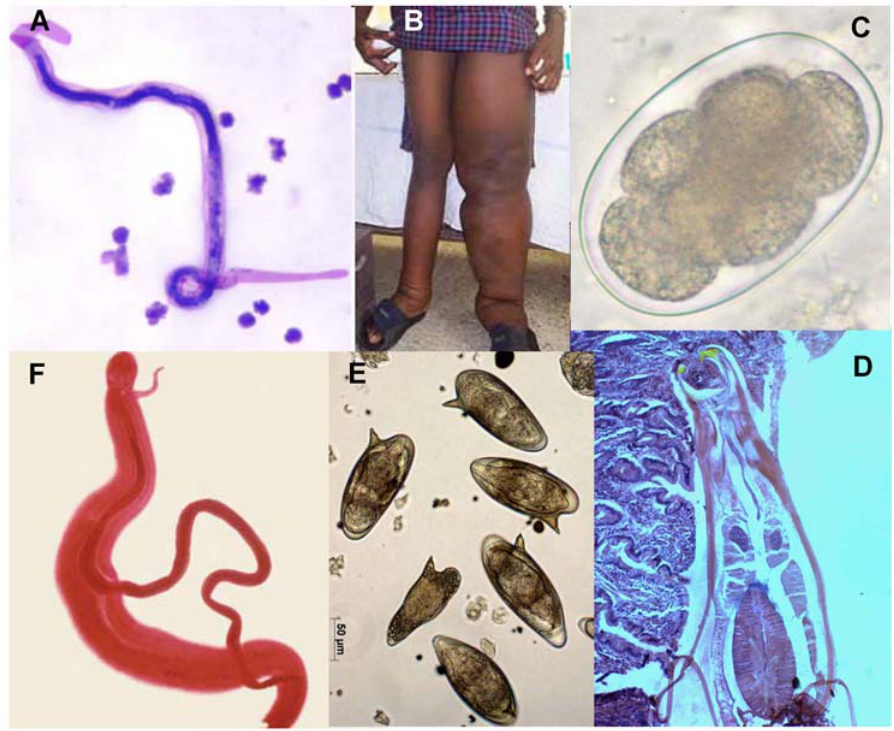
Figure 1. Montage of some of the major human helminth parasites, their developmental stages, and disease pathology. (A) Microfilaria of Brugia malayi in a thick blood smear, stained with Giemsa (http://www.dpd.cdc.gov/dpdx/html/frames/a-f/filariasis/body_ Filariasis_mic1.htm); the microfilaria is about 250 m m in length. (B) Patient with lymphedema of the left leg due to lymphatic filariasis (http:// www.cdc.gov/ncidod/dpd/parasites/lymphaticfilariasis/index.htm). (C) Hookworm egg passed in the stool of an infected person; the microscopic egg, barrel-shaped with a thin wall, is about 70 6 40 m m in dimension. (D) longitudinal section through an adult hookworm attached to wall of small intestine, ingesting host blood and mucosal wall. The parasite is about 1 cm in length. (E) Eggs of Schistosoma mansoni . The egg is about 150 6 50 m m in dimension; the lateral spine is diagnostic for S. mansoni in comparison to the other human schistosome species. Fibrotic responses to schistosome eggs trapped in the intestines, liver, and other organs of the infected person are the cause of the schistosomiasis pathology and morbidity. (F) A pair of adult worms of the blood fluke Schistosoma mansoni ; the more slender female worm resides in the gynecophoral canal of the thicker male. The worms are about 1.5 cm in length, and live for many years (http://www.dpd.cdc.gov/dpdx/HTML/ImageLibrary/Schistosomiasis_il.htm ).